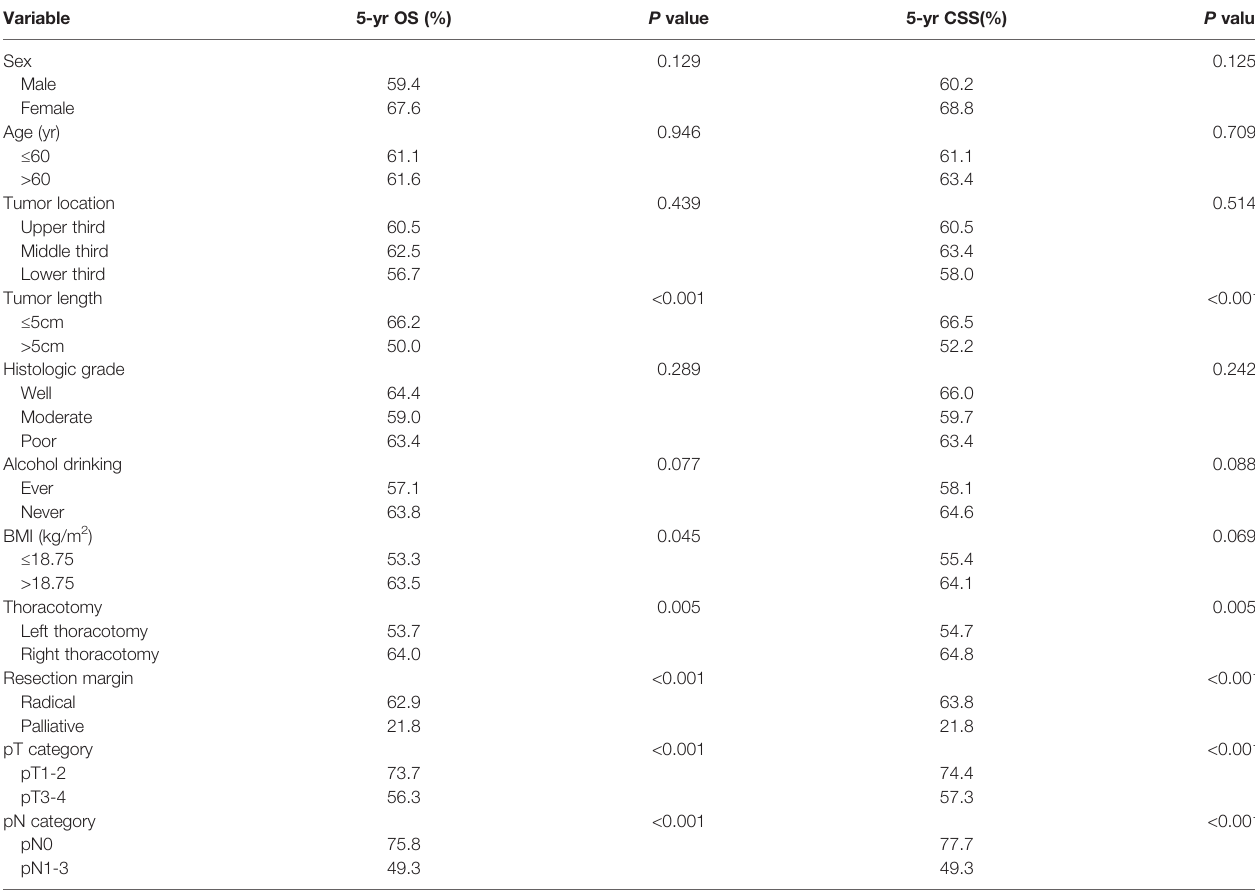
TABLE 2 | Univariate analysis in regard to overall survival and cancer-speci fi c survival according to clinicopathological factors. Variable 5-yr OS (%) P value 5-yr CSS(%) P value